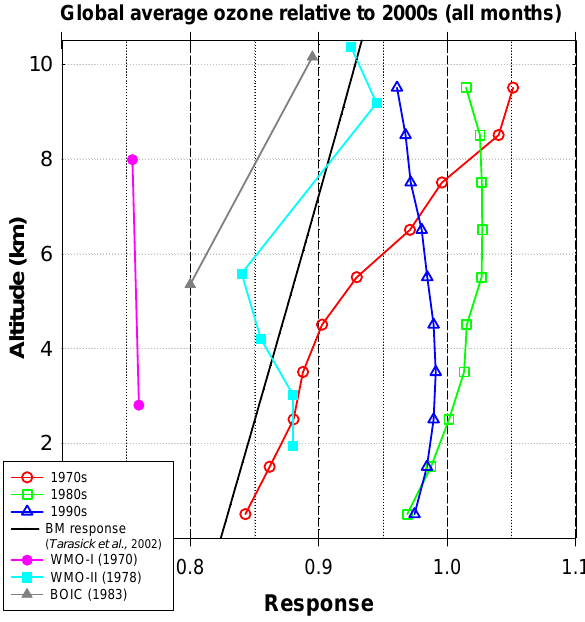
Figure 8 - Unsmoothed (5ºx5º pixel averaged) maps at 4-5 km, for January (01) and July (07), for each decade since 1970. Figure 9 - Unsmoothed (5ºx5º pixel averaged) maps at 1-2 km, for January (01) and July (07), for each decade since 1970. Global average ozone relative to 2000s (all months)